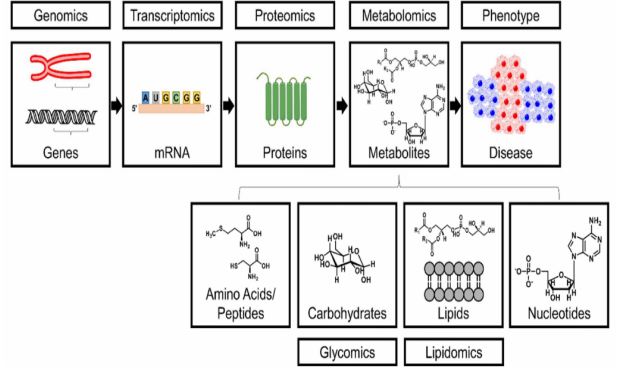
Figure 1. A simplified overview of several “omics” methodologies. Analysing metabolites, including amino acids, peptides, carbohydrates, lipids, and nucleotides that vary in response to biological disturbances which may show up as various environmental changes, is the focus of the field of metabolomics. Adapted with permission from Matich et al.